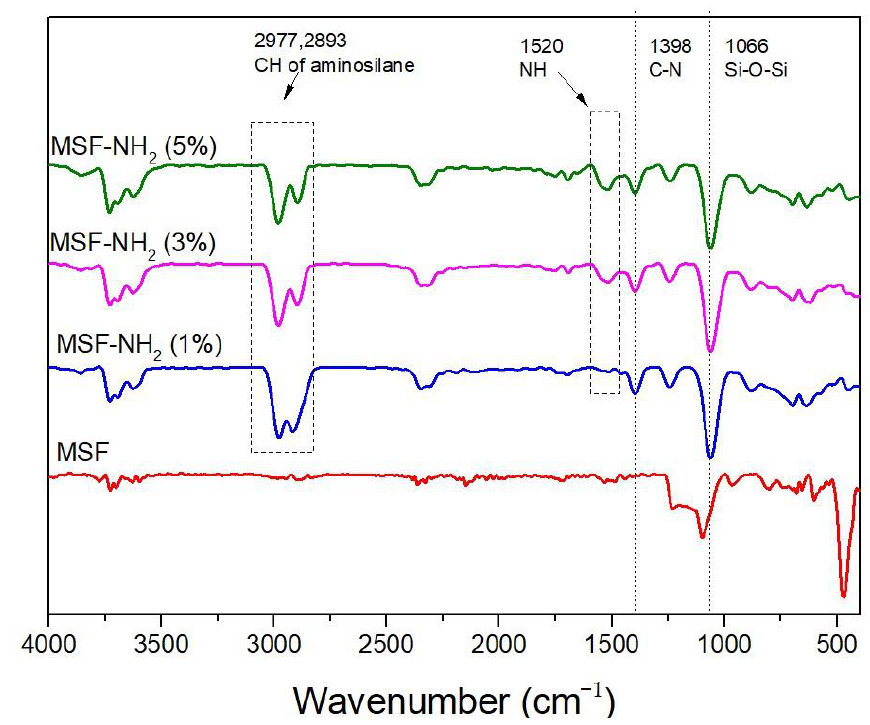
Figure 3. FTIR spectra of aminopropyl-modified MSFs and MSF on FTO glass .